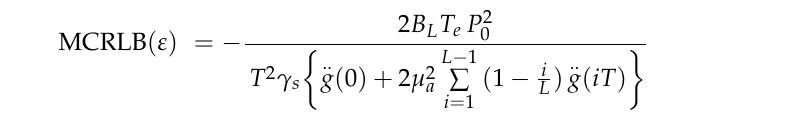
.. g ( t 0 ) as the second-order derivative of g ( t ) = with whereas L is equivalent to 1/ ( 2 B L T e ) rounded to an integer number.